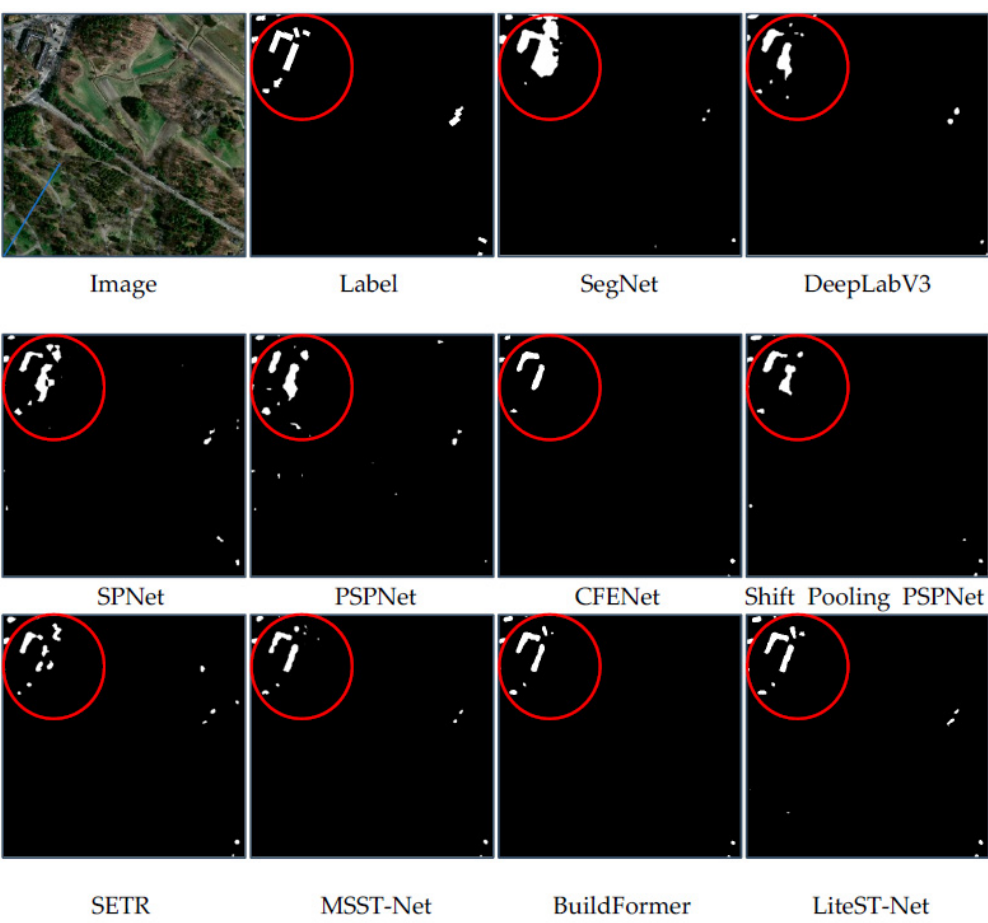
Figure 7. Prediction of small buildings on the Massachusetts building test dataset. The red circle shows the predicted results of various models for the same small building.